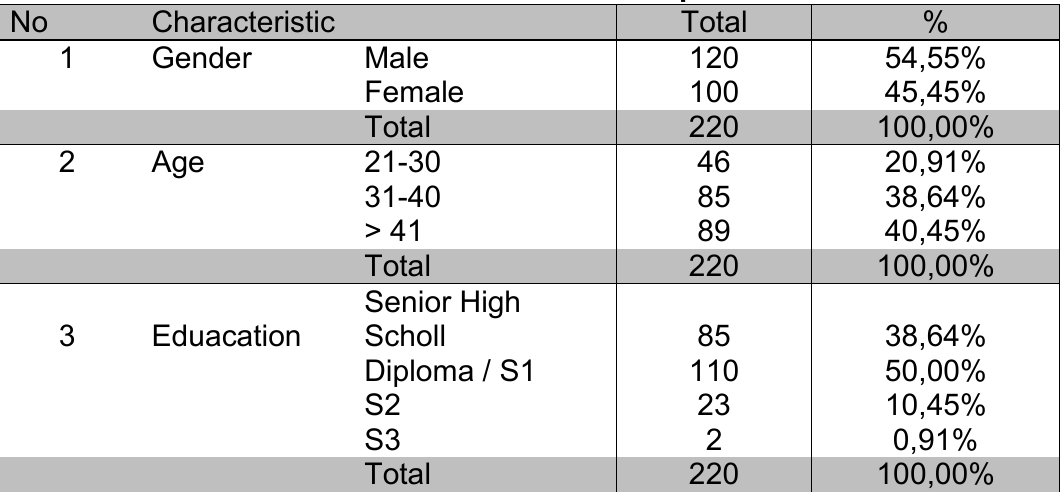
Table 2. Characteristics of